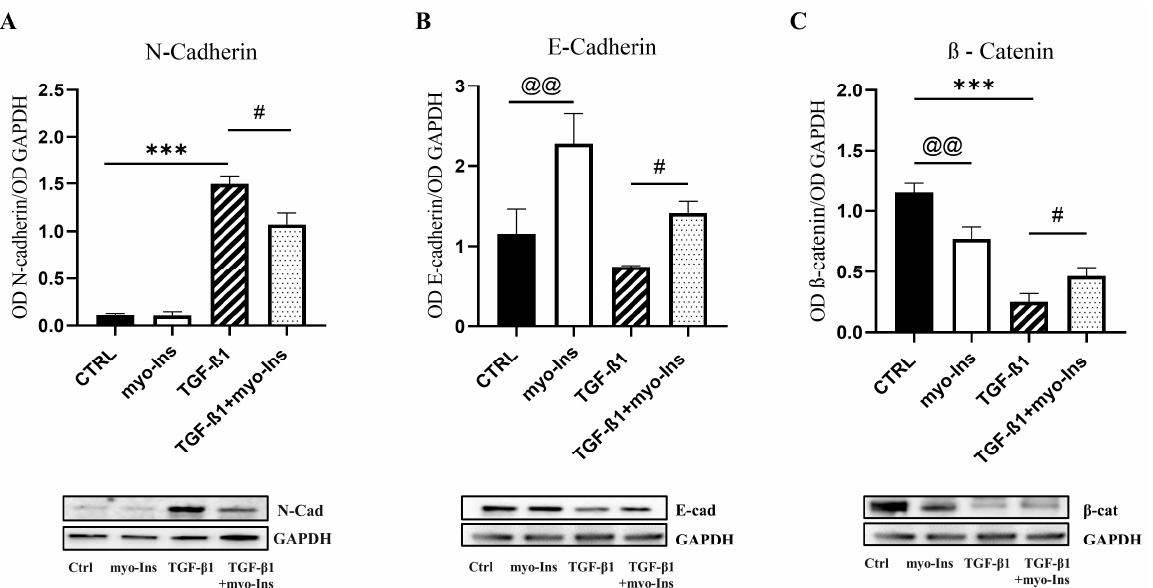
Figure 8. Myo-Ins regulates the expression of cell-to-cell junction markers when added after five days of TGF- β 1 induction. Graphs representing Western blot relative expression of N-cadherin ( A ), E-cadherin ( B ), and β -catenin ( C ) in MCF-10A cells treated with TGF- β 1 alone or in combination with myo-Ins for six hours of three independent experiments (mean ± SEM). The treatment with myo-Ins significantly ( − 40%) reduces the expression of N-cadherin, while promoting the expression of E-cadherin up to the level shown by the control samples. Moreover, myo-Ins rescues the TGF- β 1- induced inhibition upon β -catenin. Although β -catenin increases up to two-fold when compared to transformed cells, the pre-TGF- β 1 values are not reached after myo-Ins treatment. Each sample has been normalized by using the relative expression for GAPDH. *** p < 0.001 (One-way ANOVA). The uncropped blots are shown in Figure S2. # p < 0.05; @@ p < 0.01. Legend: *: TGF- β 1 vs. CTRL; # TGF- β 1+myo-Ins vs. TGF- β 1; @: myo-Ins vs.